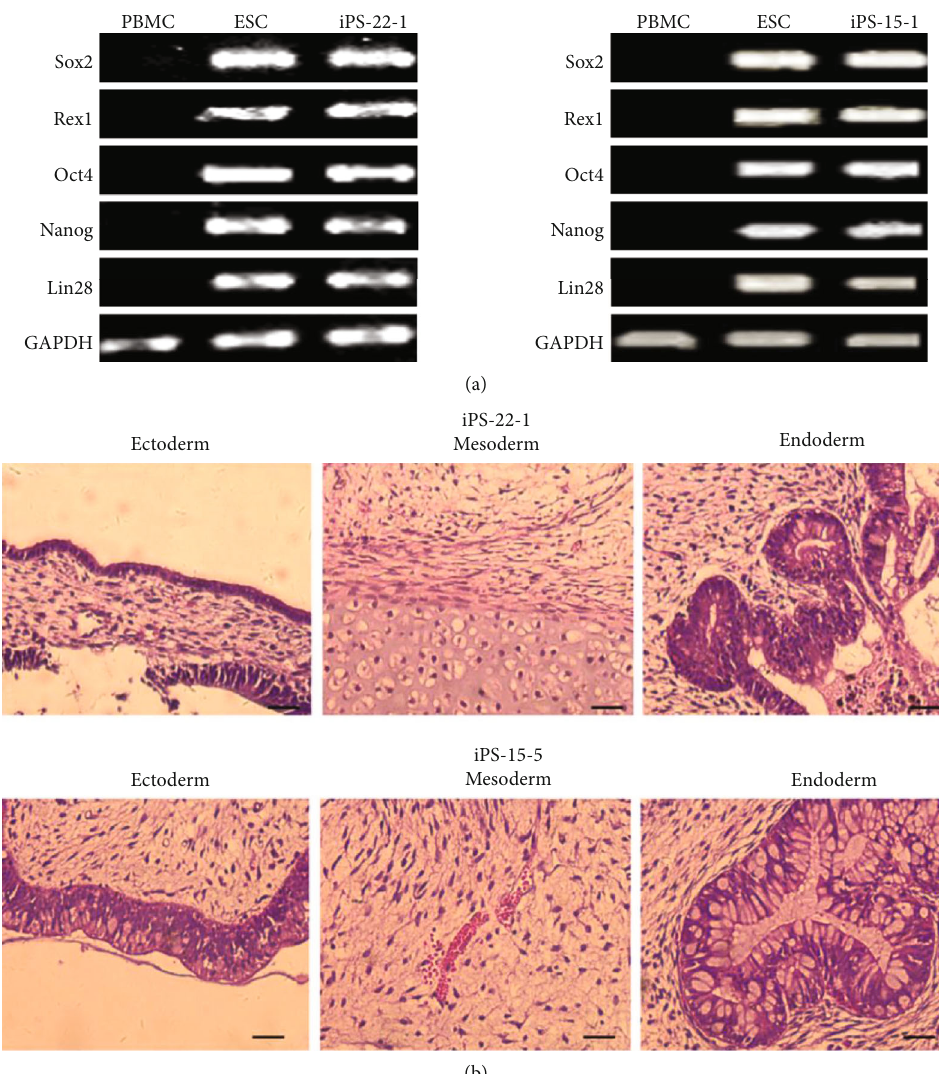
Figure 2: The results of RT-PCR and teratoma formation. The expressions of Oct4, Sox2, Nanog, Rexl, Lin28, and other genes were identi fi ed by RT-PCR. Sox2, Rex1, Oct4, Nanog, and Lin28 gene of two strains of cells were positive in agarose gel electrophoresis, which was similar to H9 cells, but negative in primary PBMC (a). The formation of teratoma was observed in vivo, and its ability of multidirectional di ff erentiation was tested. iPSCs were tested for tumorigenesis in nude mice. The two iPSCs had the potential to di ff erentiate into three layers